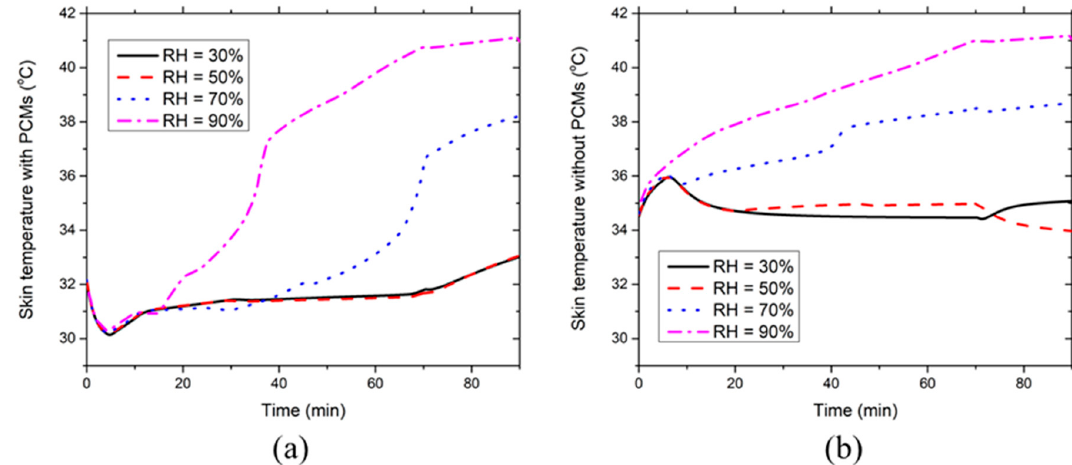
Figure 11. Effect of environmental RH on the time course of chest skin temperatures ( a ) with and ( b ) without PCMs and insulation layers at the ambient temperature of 40 °C.